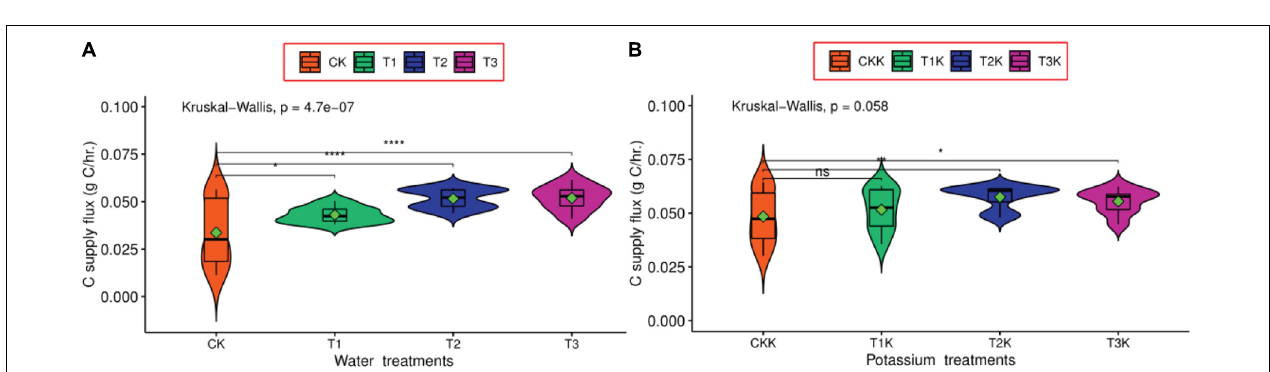
FIGURE 2 | The sucrose synthase (SuSy), sucrose phosphate synthase (SPS), starch phosphorylase (SP), and starch synthase (AGPase) activity in source leaf. Water include 2 level: water deficit (WD) and CK, and potassium level contain without potassium (K 0 ) and with potassium (K 1 ). (A) SuSy activity in leaf under deficit irrigation and potassium application condition. (B) SPS activity in leaf under deficit irrigation and potassium application condition. (C) SP activity in leaf under deficit irrigation and potassium application condition. (D) AGPase activity in leaf under deficit irrigation and potassium application condition. * denotes significant difference at P < 0.05, *** denotes significant difference at P < 0.001, **** denotes significant difference at P < 0.0001.